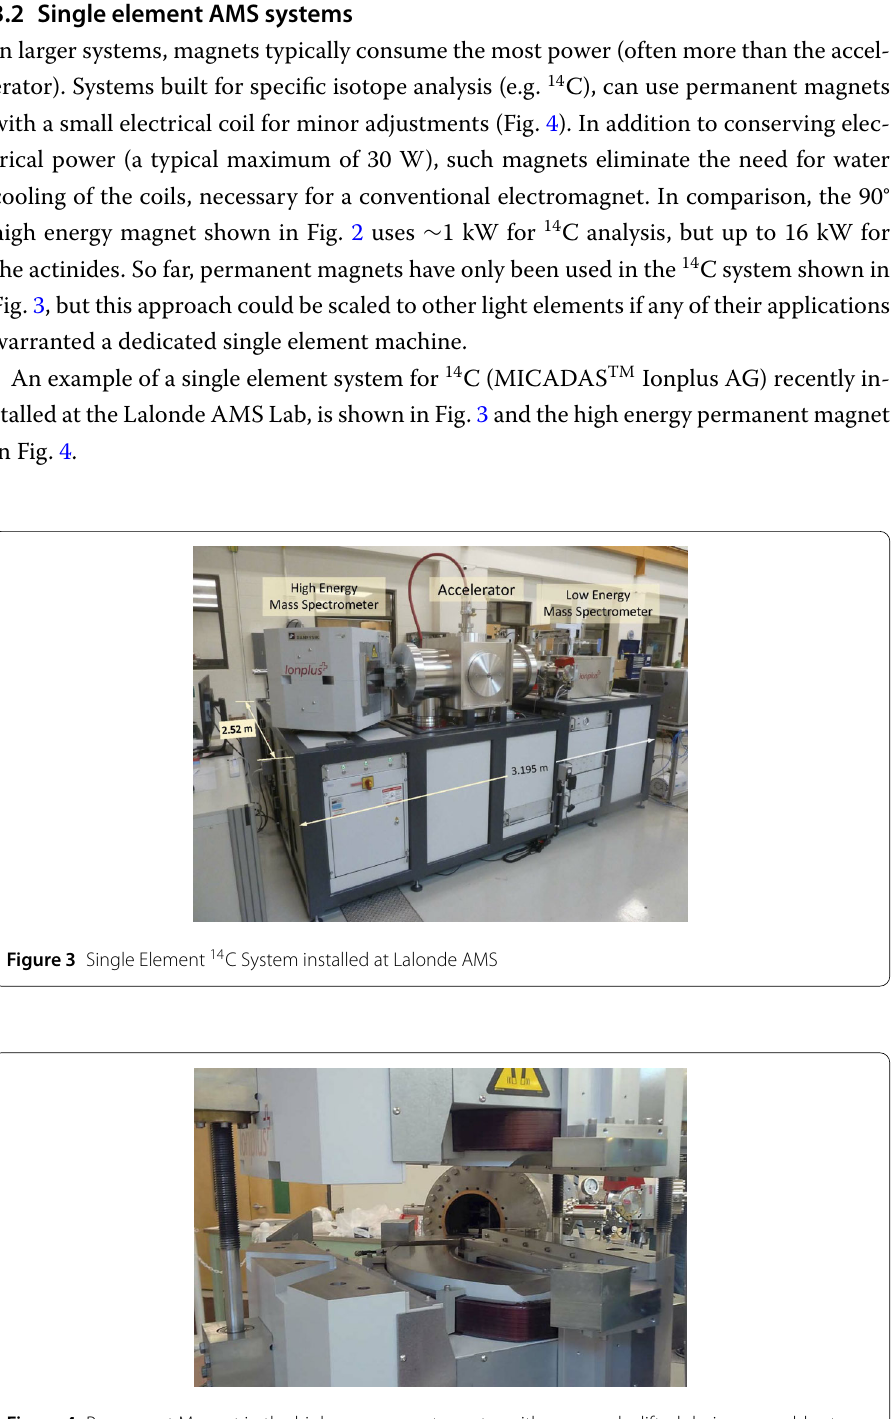
Figure 4 Permanent Magnet in the high energy spectrometer with upper yoke lifted during assembly at Lalonde. Note the small size of the trim coil compared with the space available for a water-cooled full power